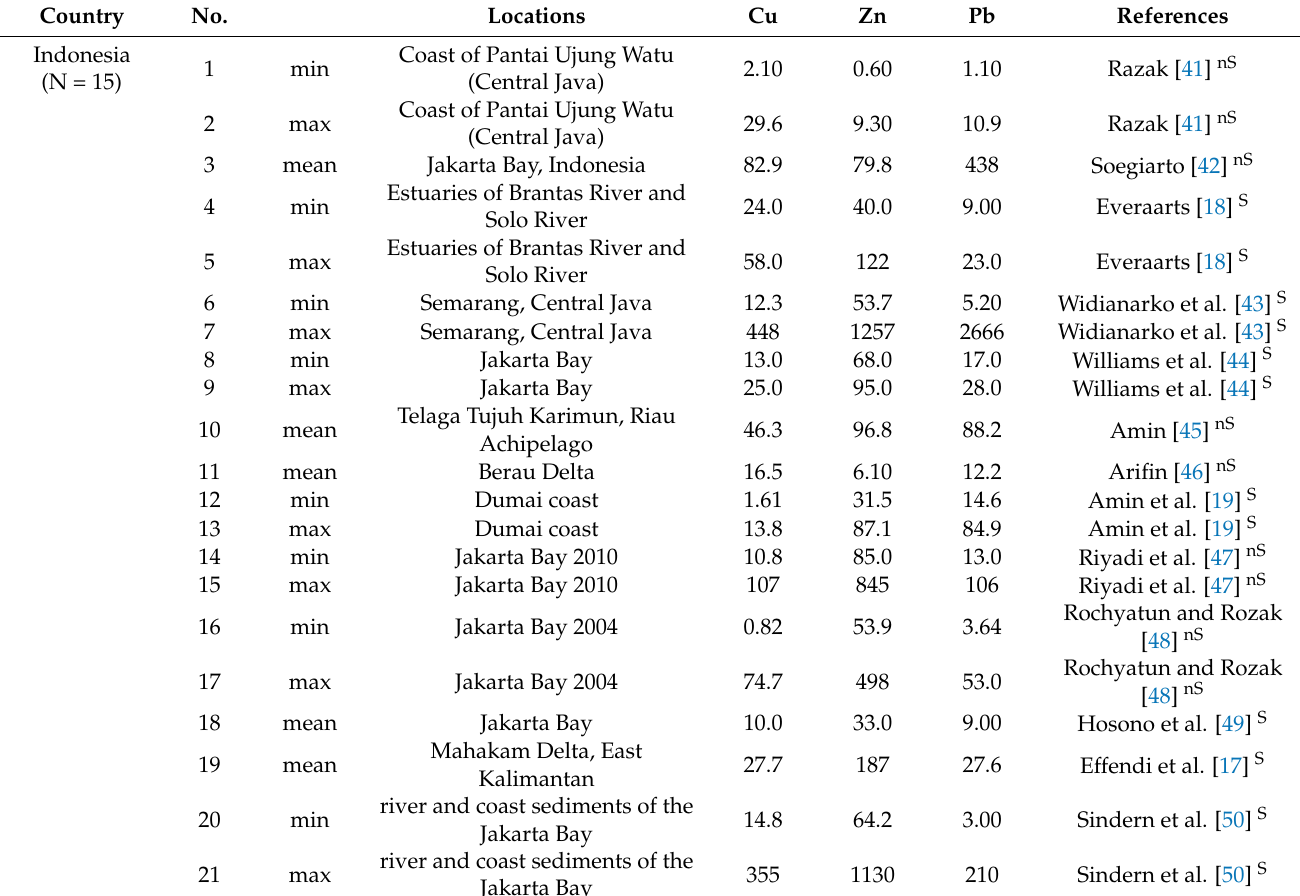
Table 2. Concentrations (mg/kg dry weight) of Cu, Pb, and Zn reported from the ASEAN-5 countries obtained from the literature from